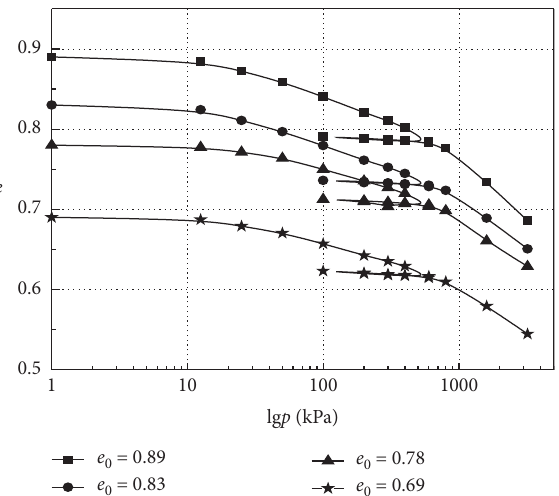
Figure 17: Relationship between E